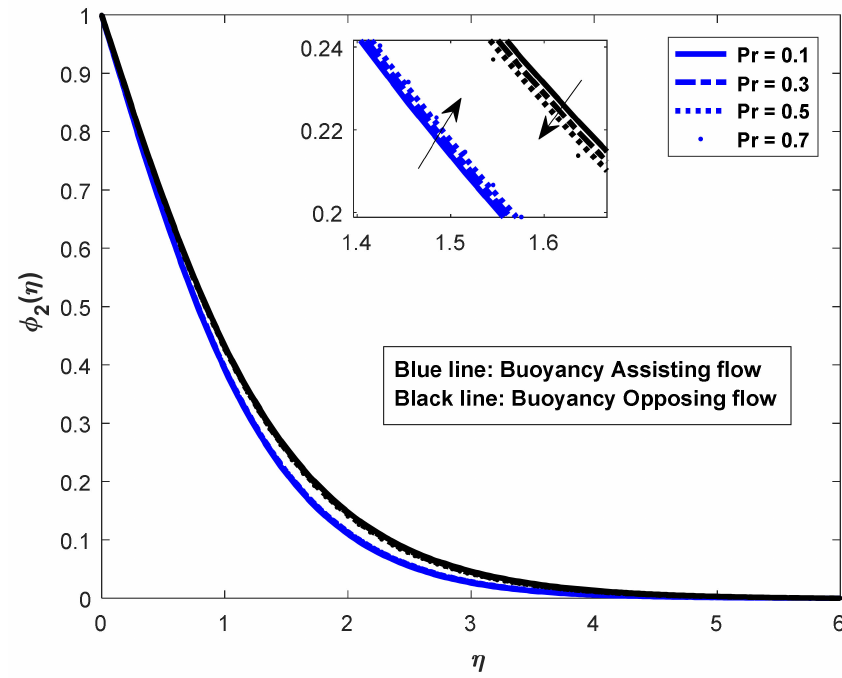
Figure 8. Pr on salt_2